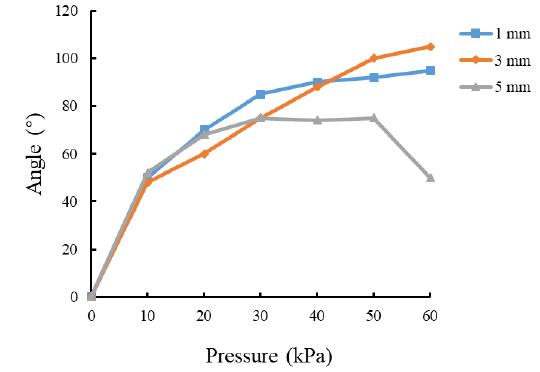
Figure 5. Effect of chamber clearance on bending properties.